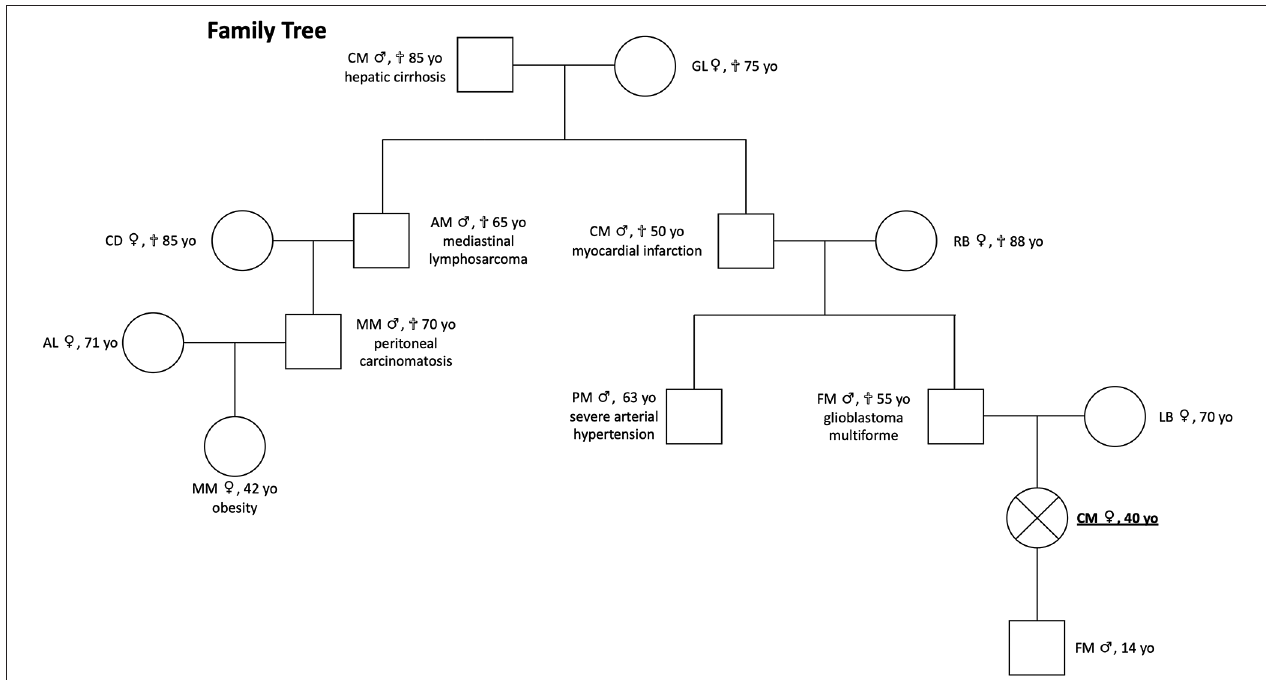
FIGURE 1 | Patient pedigree [proband positive for MAX mutation c299G > C (p.Arg100Pro, NM_00.42382)]. She presented clinical signs of multiple PGL and composite PCCs; proband’s father had a glioblastoma multiforme, and genetic testing was not performed; proband’s son is negative for clinical manifestations, and genetic analyses were not